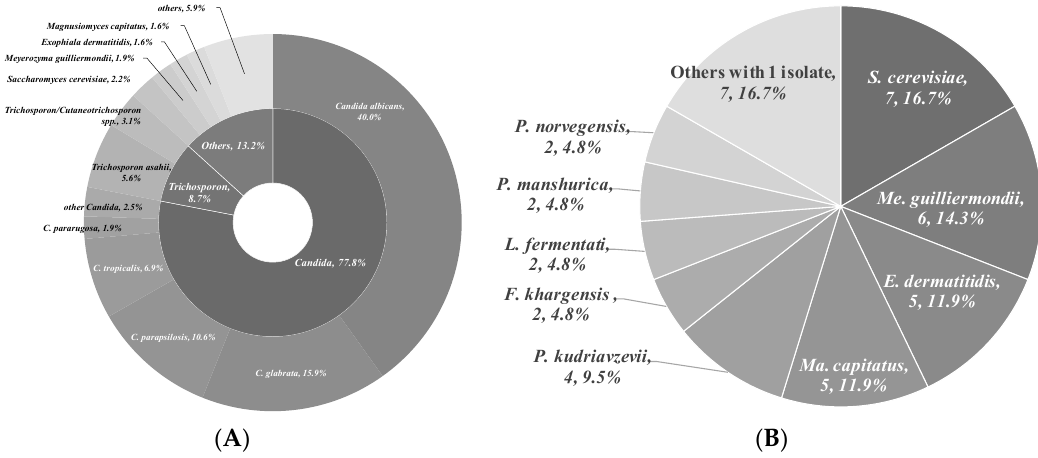
Figure 1. Scheme for the identification of oral yeast for the study. The strategy to isolate and iden- tify yeast involves: (1) preparation of oral wash samples, (2) yeast isolation, and (3) identification and confirmation of the yeast.